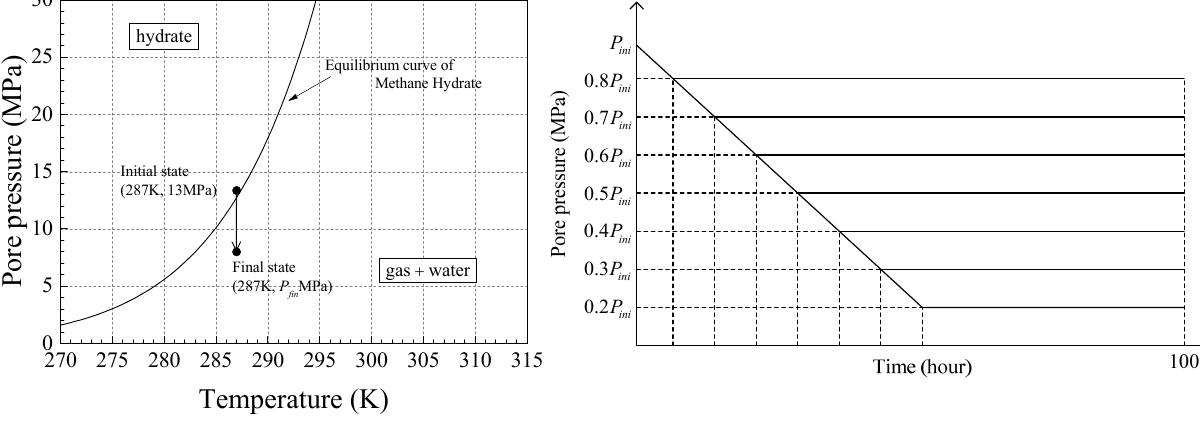
Figure 5. Conditions of change in pore pressure change at the depressurization